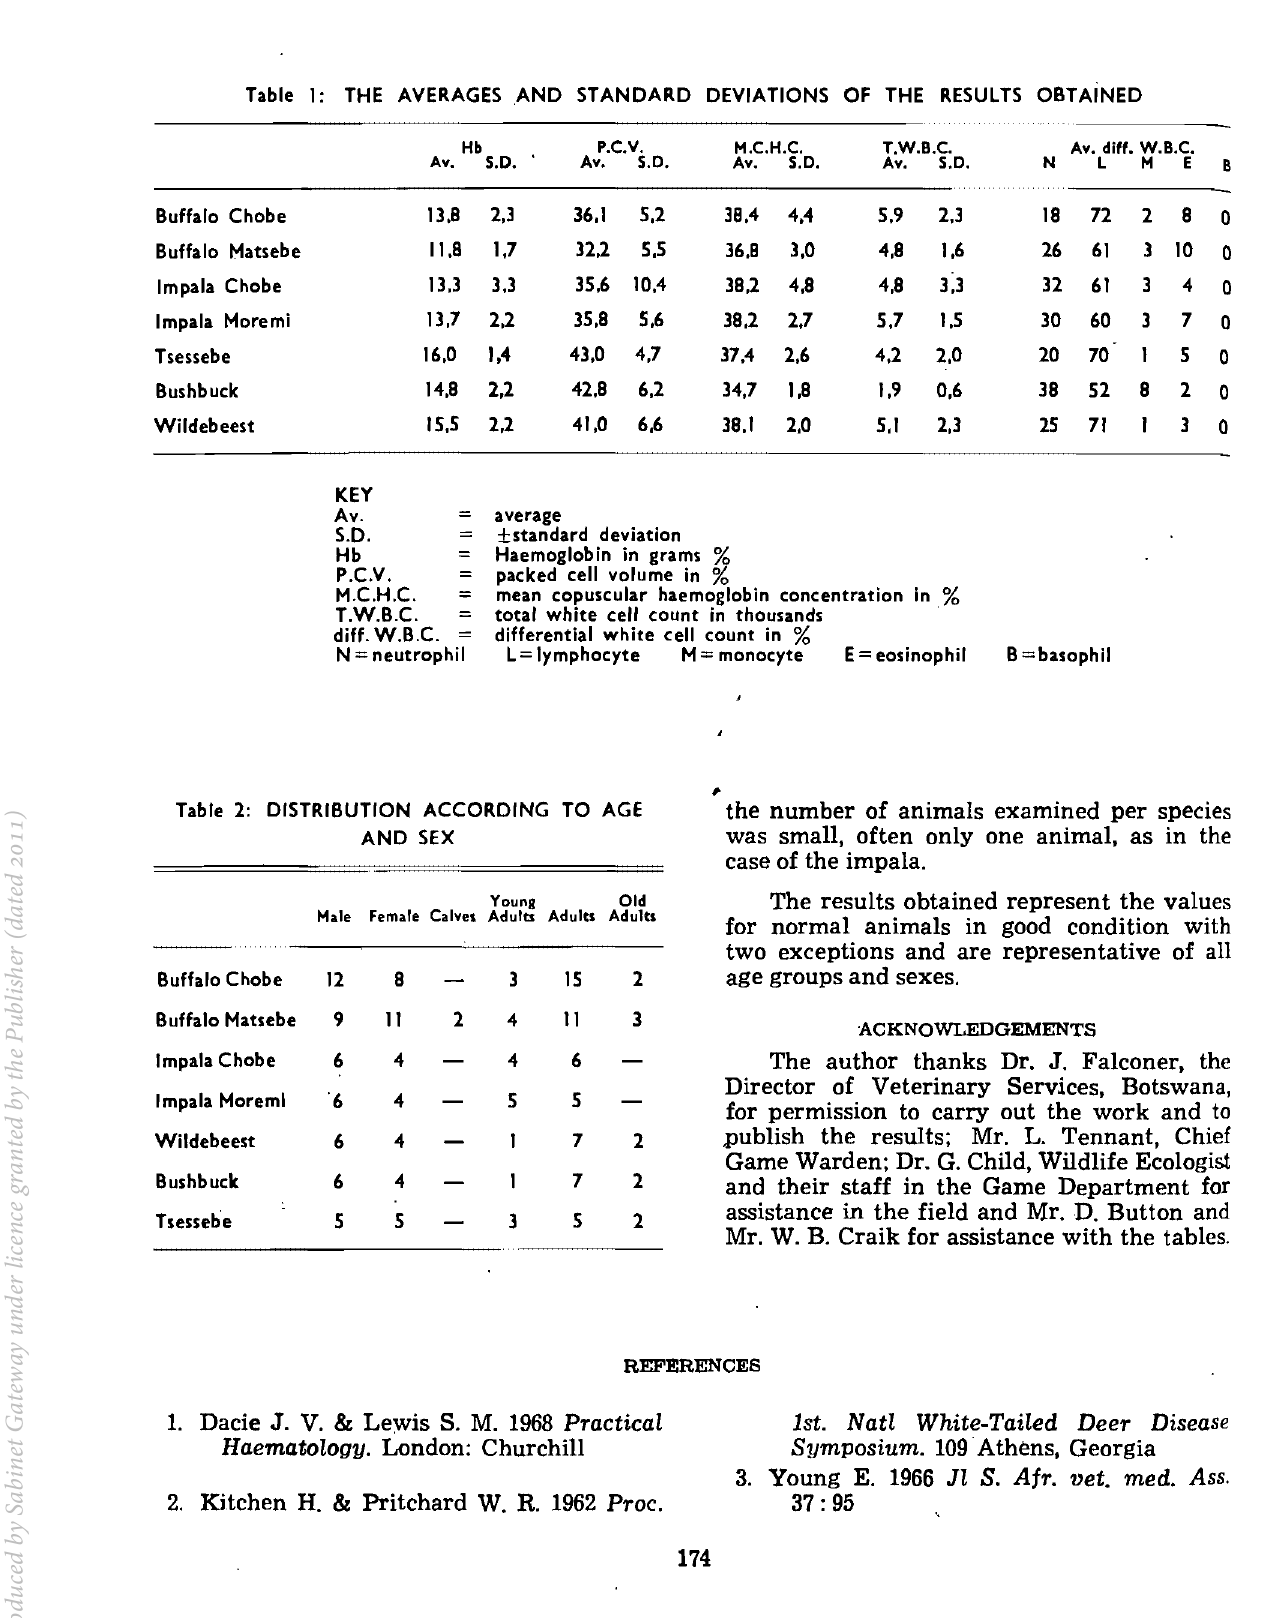
Table I: THE AVERAGES AND STANDARD DEVIATIONS OF THE RESULTS OBTAiNED Hb